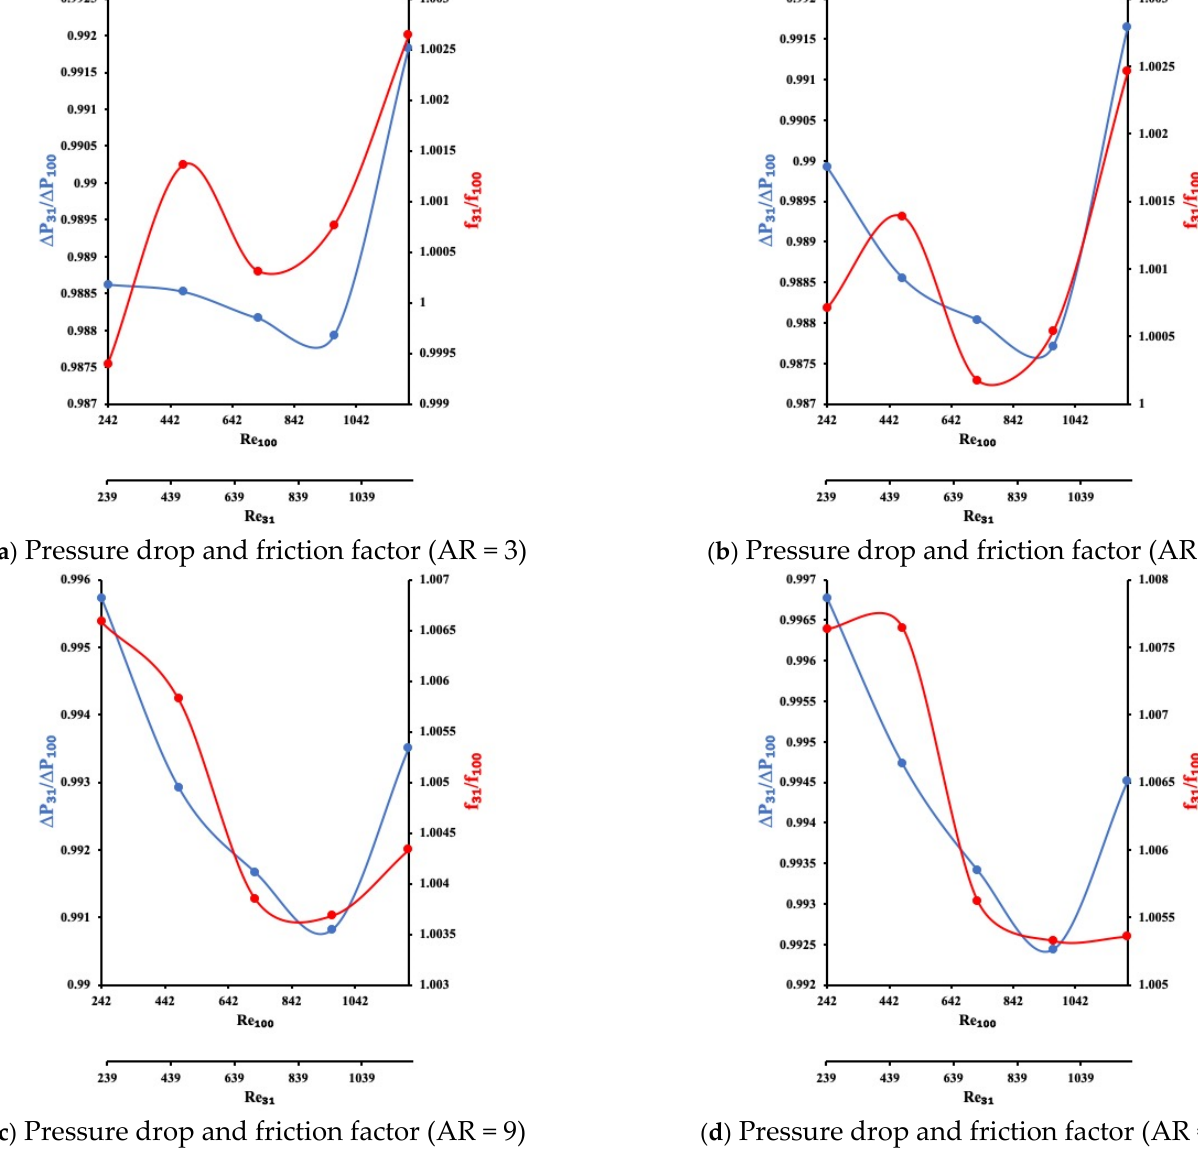
Figure 9. The ratio of the pressure drop and friction factor between nanofluid with different nanoparticles diameter.